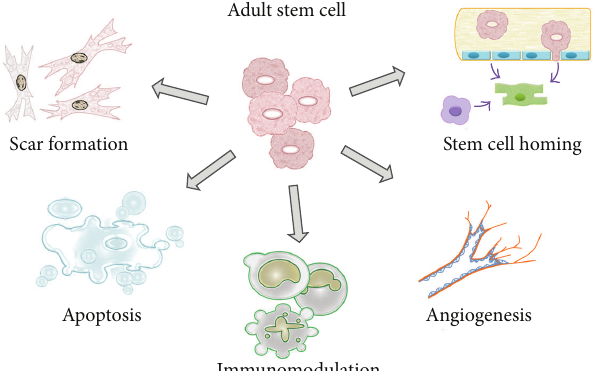
Figure 1: The influence of MSC on the niche. According to the signaling factors that the MSC are exposed, different decisions may be taken, where the main ones are those that are involved in proliferation and cellular differentiation. The MSC capture and send molecular signals, which change the niche, either by modulating the immune system as providing mechanisms for tissue repair effectors, involving since activation of cell homing, cell apoptosis, induction of the formation of new blood vessels, and the healing